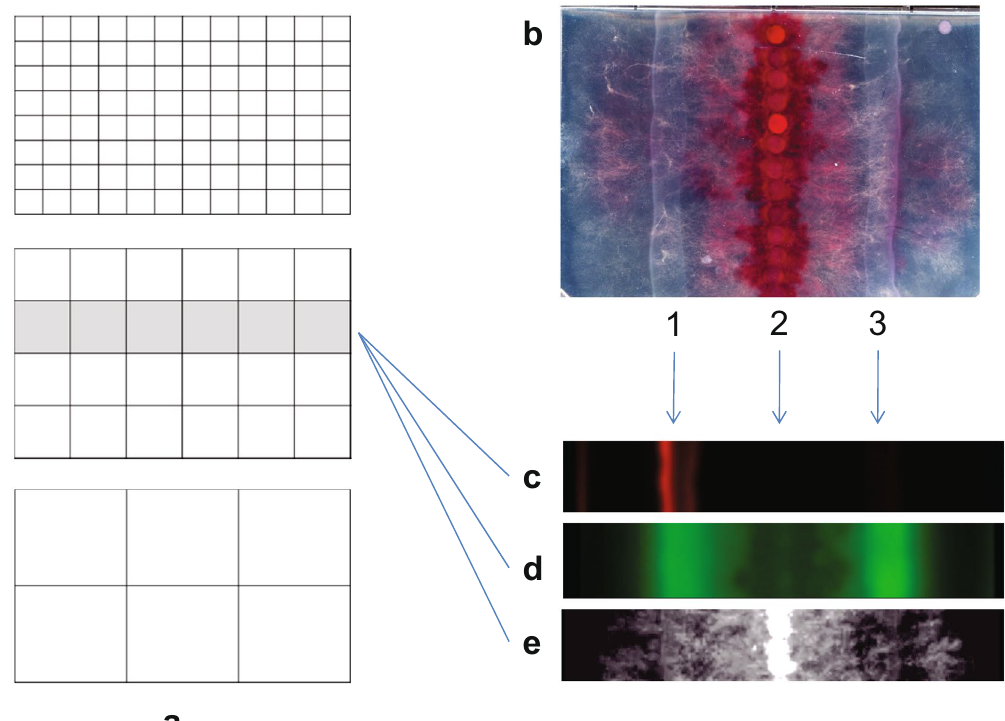
Figure 1. Recording images of plates using a plate reader. ( a ) The plate area with the interacting fungus can be defined as containing 96, 24 or 6 “wells” with zero thickness walls that can each be scanned (30 × 30 readings). ( b ) Scan of a Nunc OmniTray plate (120 × 80 mm) (Thermo Fisher Scientific, Waltham, MA) using a standard flatbed optical document scanner containing the fungus F. graminearum inoculated, with a row of agar plugs cut from a colony, at position 2. P. fluorescens In5 containing a plasmid with nunF -promoter-mCherry construct was inoculated as a streak at position 1 and the bacterium containing a plasmid with the same construct but lacking the promoter was inoculated as another streak at position 3. ( c–e ) Images constructed from scans by the BMG LABTECH microplate reader (BMG LABTECH, Offenburg, Germany) in different channels of the same row of 6 “wells”. ( c ) Red fluorescence (Excitation filter 584 nm Emission filter 620–10 nm) recording the mCherry signal. ( d ) Green fluorescence (Excitation filter 485-12 Emission filter 520) recording the bacterial fluorescent siderophore pyoverdine and also a fungal fluorescent compound. ( e ) Absorbance 660 nm measuring optical density (OD) used to measure biomass (660 nm is not absorbed by the red fungal